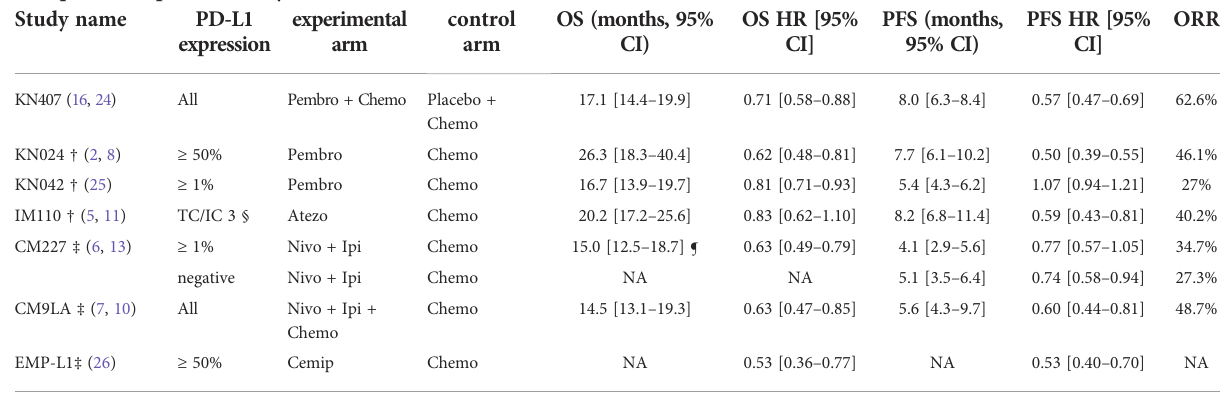
TABLE 1 Key clinical trials that tested ICI regimens for treatment-naïve patient. A. Sq-NSCLC, positive